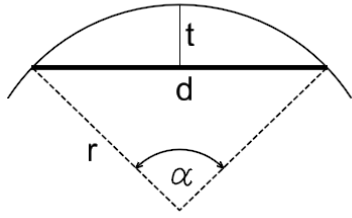
Figure 2. Relationships between the parameters describing the arc.